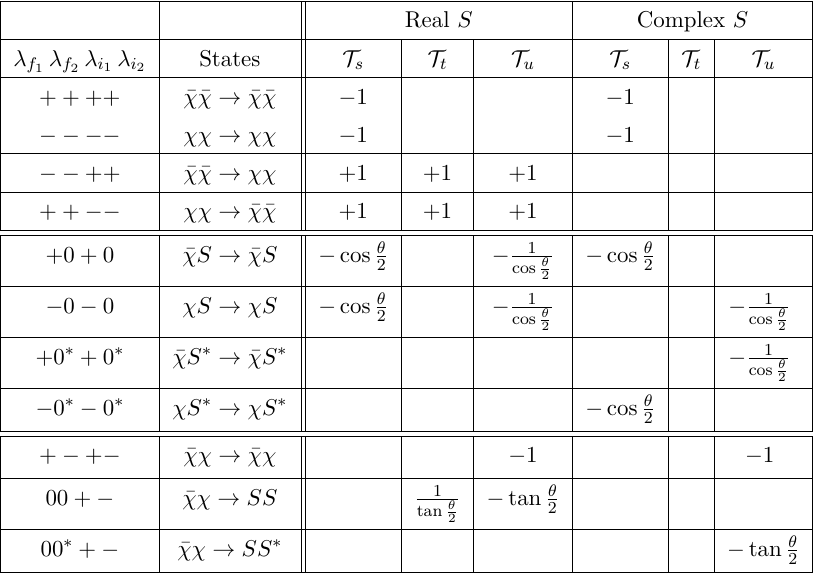
Table 3 . Lorentz part of the amplitudes for the models of the second class divided by y 2 . In the complex scalar case also the 0 ∗ 0 ∗ + − amplitudes are zero. In the helicity amplitudes the notation 0 ∗ indicates the scattering involving the conjugate of the scalar S